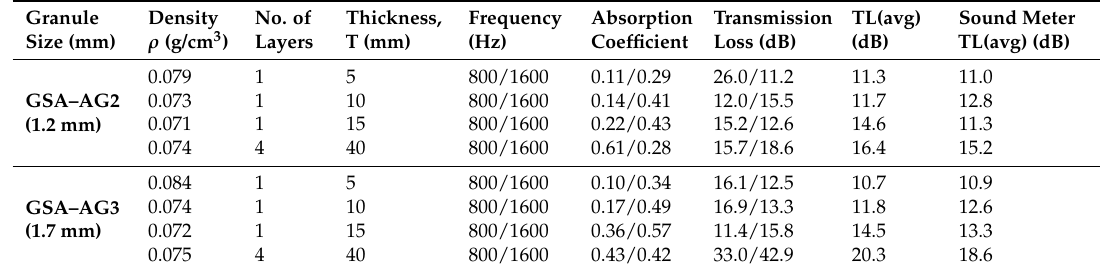
Table 2. Densities, Absorption Coefficient and Transmission Loss of GSA–SDS Composites.